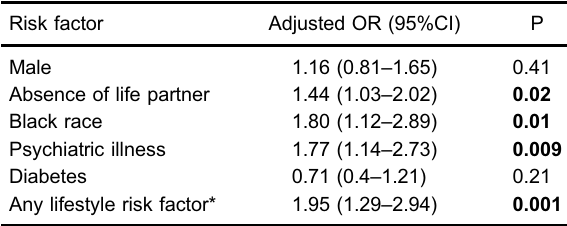
Table 3. Risk factors for loss to follow-up in multivariate